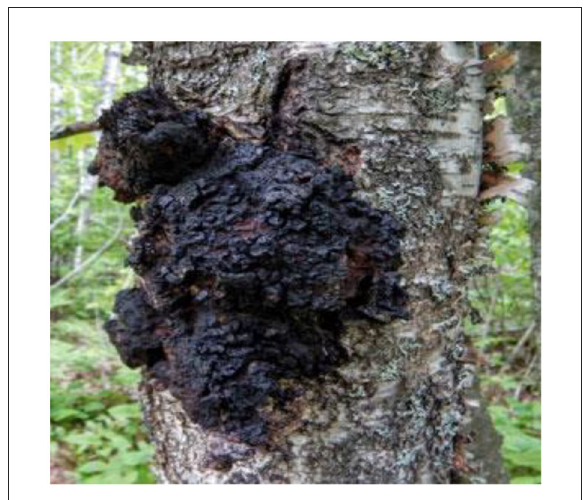
FIGURE10 Chaga mushroom ( Inonotus obliquus ) is a parasitic fungus from the family Hymenochaetaceae with potential in oncology.